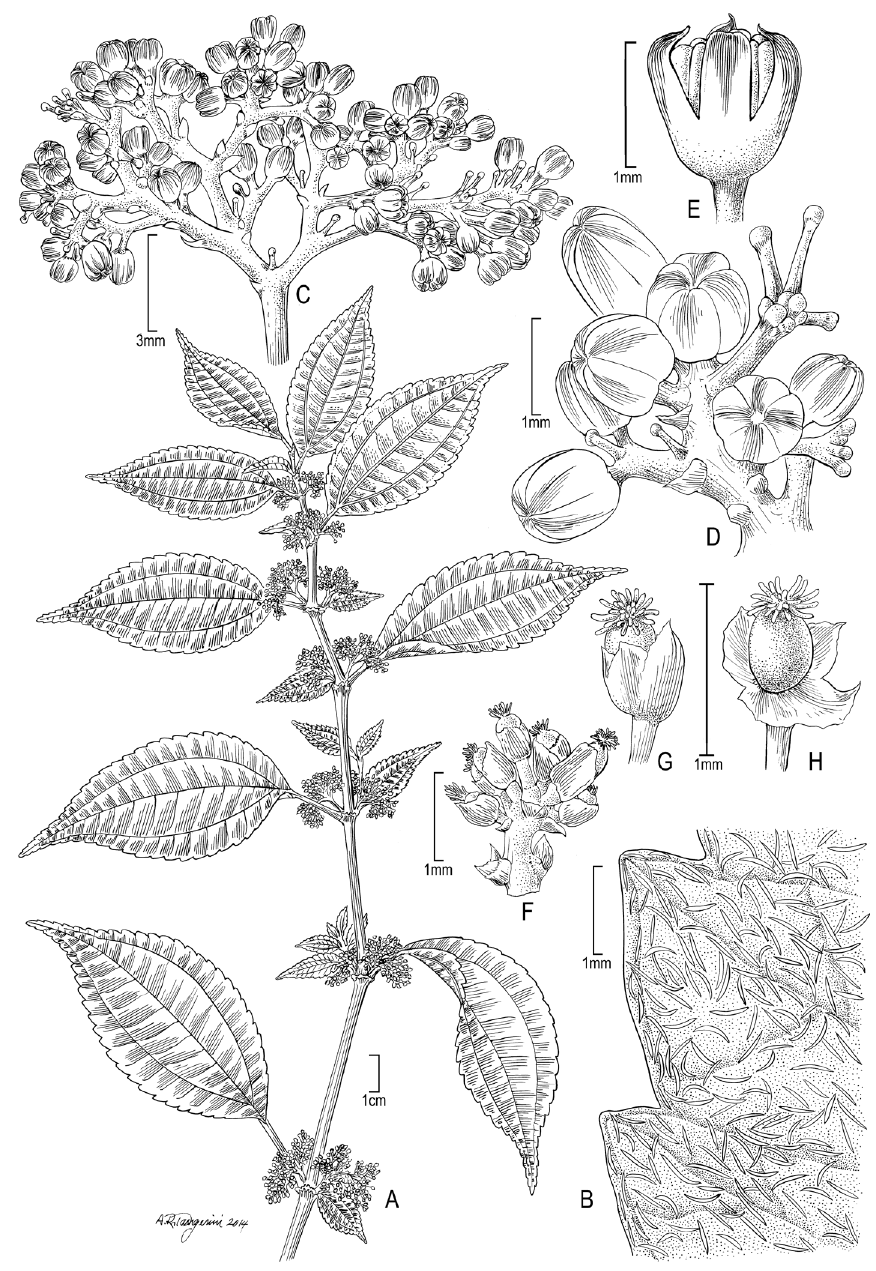
Figure 2. Pilea miguelii . A Habit; note the unequal leaf laminae at each node B Leaf detail (major lamina upper surface) showing cystoliths C Staminate inflorescence D Detail of staminate inflorescence. E Staminate flower showing tepals covering anthers F Pistillate inflorescence G Pistillate flower H Pistil- late flower with tepals teased apart to show mature ovary. ( A from B. Stergios & M. Niño 16028 (PORT); B – E from B. Stergios & M. Niño 16028 (US); F – H from J.A. Steyermark 55767